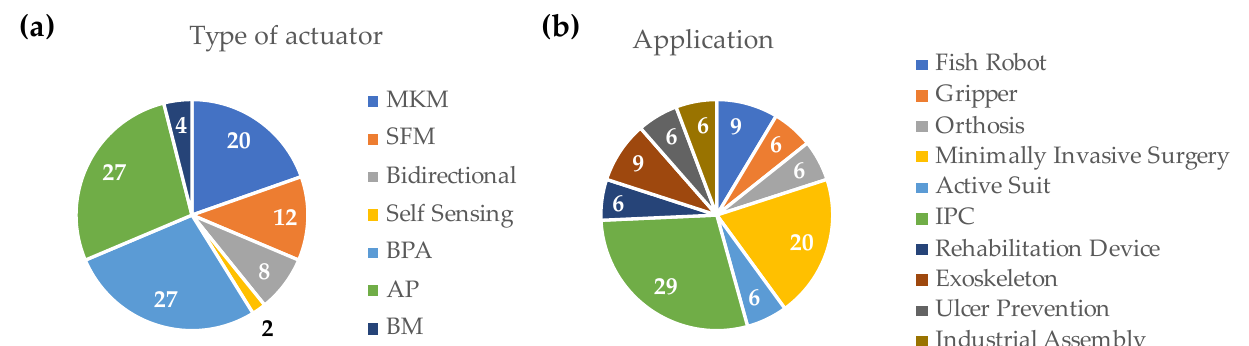
Figure 19. Actuators type ( a ) and proposed applications ( b ). The values are expressed in percentages. Most applications belong to the biomedical field, though relevant interest is also high- lighted in applying PAMs to wearable devices, such as exoskeletons and active suits. This result is likely related to the inherent compatibility between soft actuators and natural structures such as the human body. In this sense, the improved flexibility and compli- ance allowed by PAMs seem convenient and advantageous for the design of mechani- cal/mechatronic systems which interact with humans, especially when safety is critical. On the other hand, the heaviness of the PAM power supply source discourages the devel- opment of portable or wearable